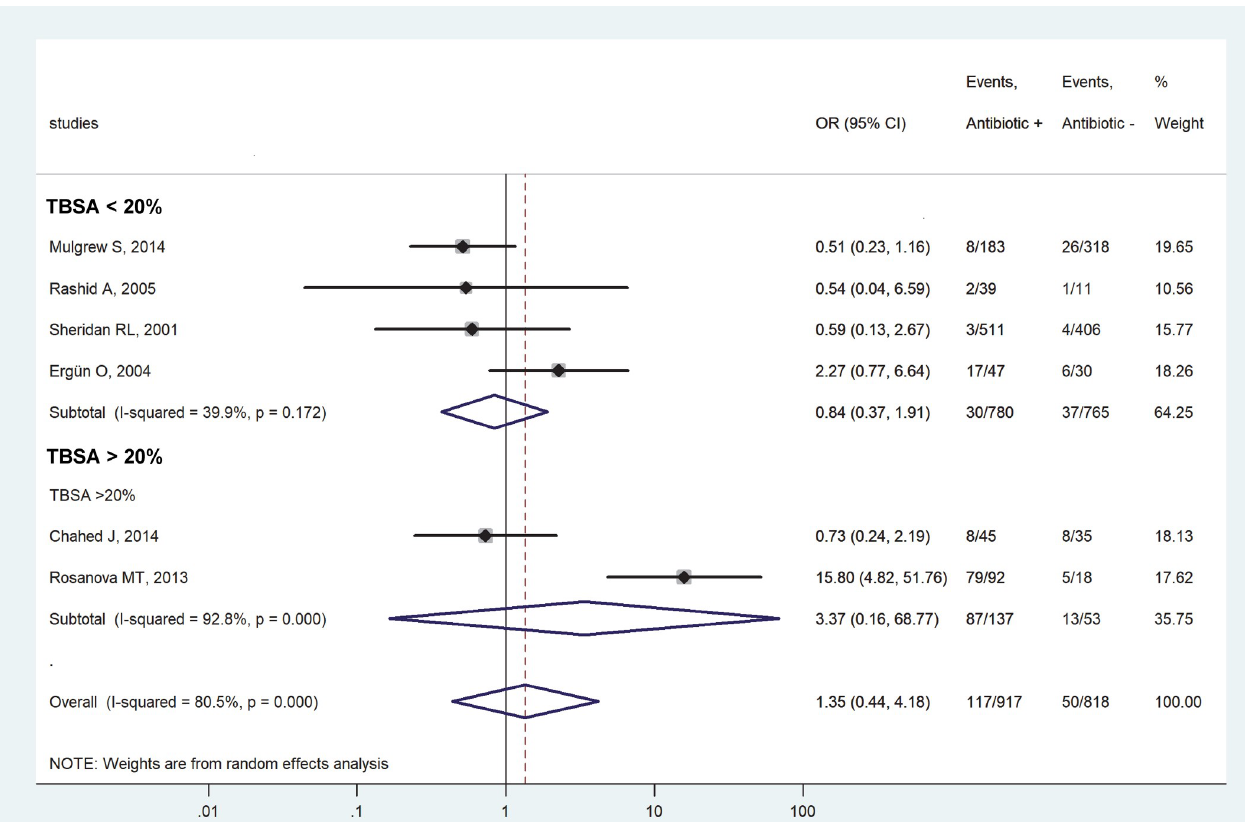
Fig 4. Forest plot of the odds ratios (ORs) for all infectious complications in pediatric patients with burn injuries who received versus those who did not receive systemic antibiotic prophylaxis in subgroups of less than 20% (top) and more than 20% (bottom) mean extent of injury as related to the total body surface area